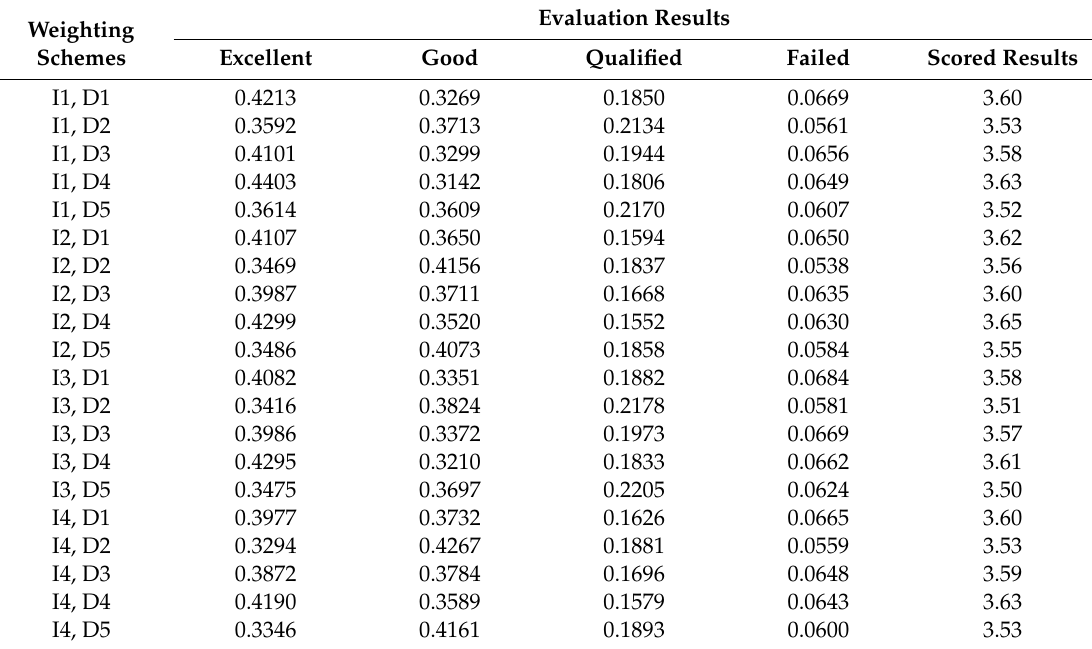
Table 2. Evaluation result of cloud model based on